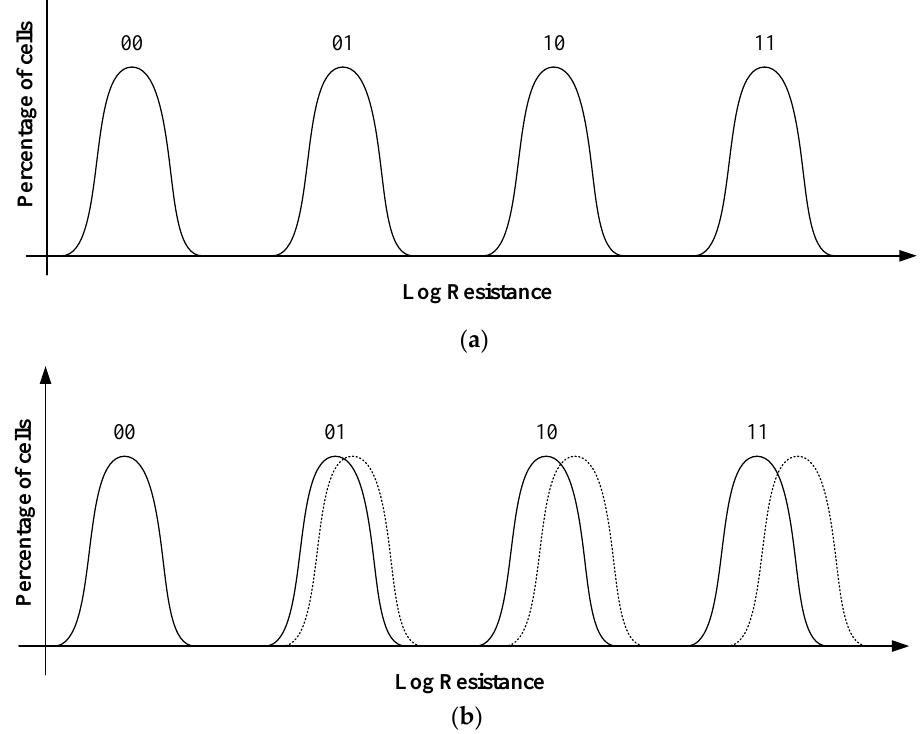
Figure 4. ( a ) Ideal resistance distribution. ( b ) Resistance distribution in reality. At present, the most widely used cell structures of PCM are 1T1R and 2T2R. 1T1R is widely used in multilevel storage because of its high storage density and simple structure, but it is easily affected by process fluctuations, which leads to the misreading of data. In contrast, 2T2R shows obvious advantages in anti-interference of process fluctuation and reliable information storage.